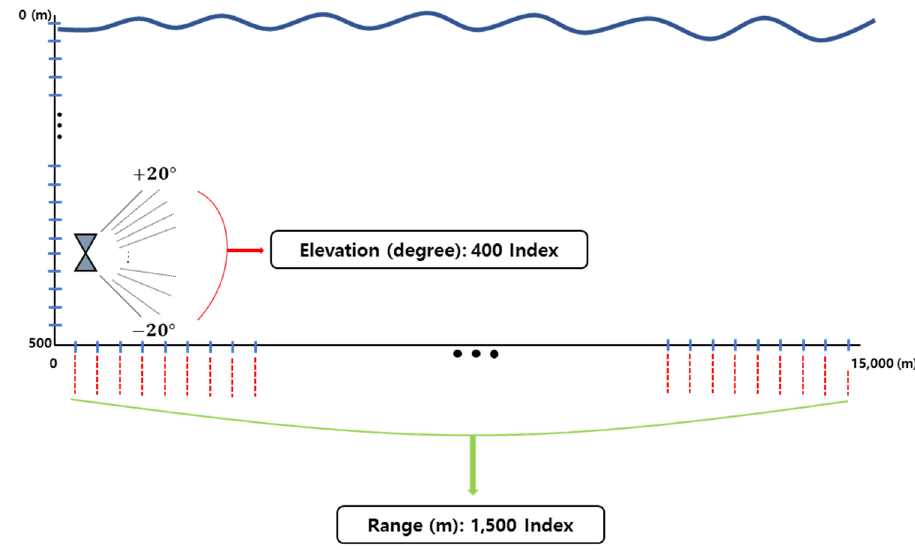
Figure 8. The ray tracing process.